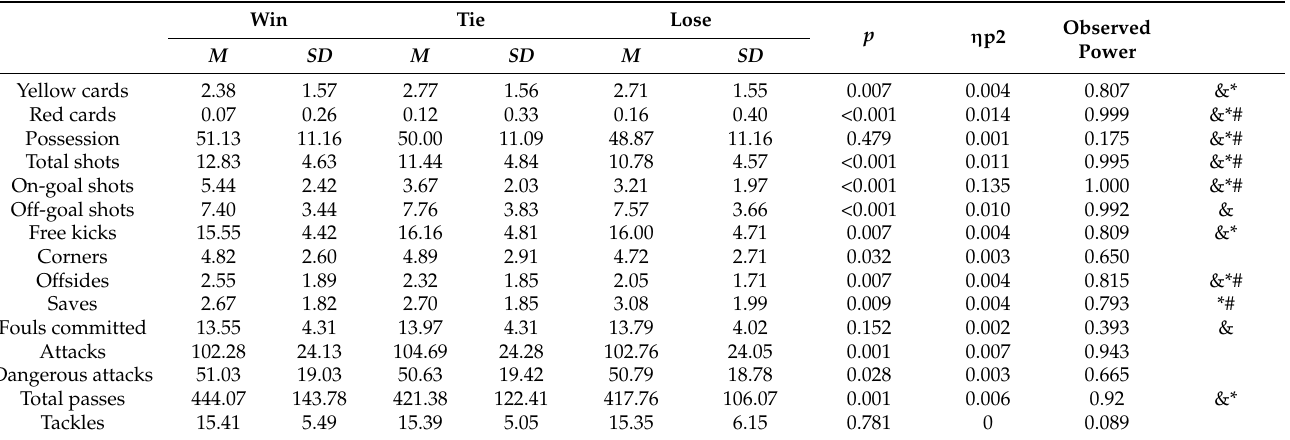
Table 4. Descriptive and inferential results and differences among groups of the results with the performance